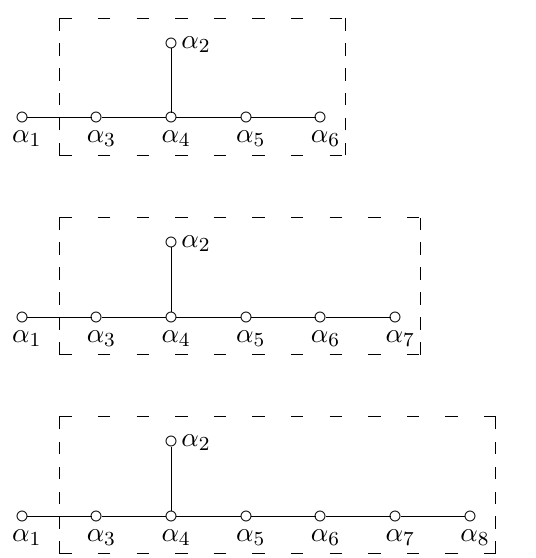
Figure 12. The Dynkin diagrams for e 6 , e 7 , e 8 , and their subdiagrams corresponding to the subalgebra so (2 N f ) (cid:26) e N f +1